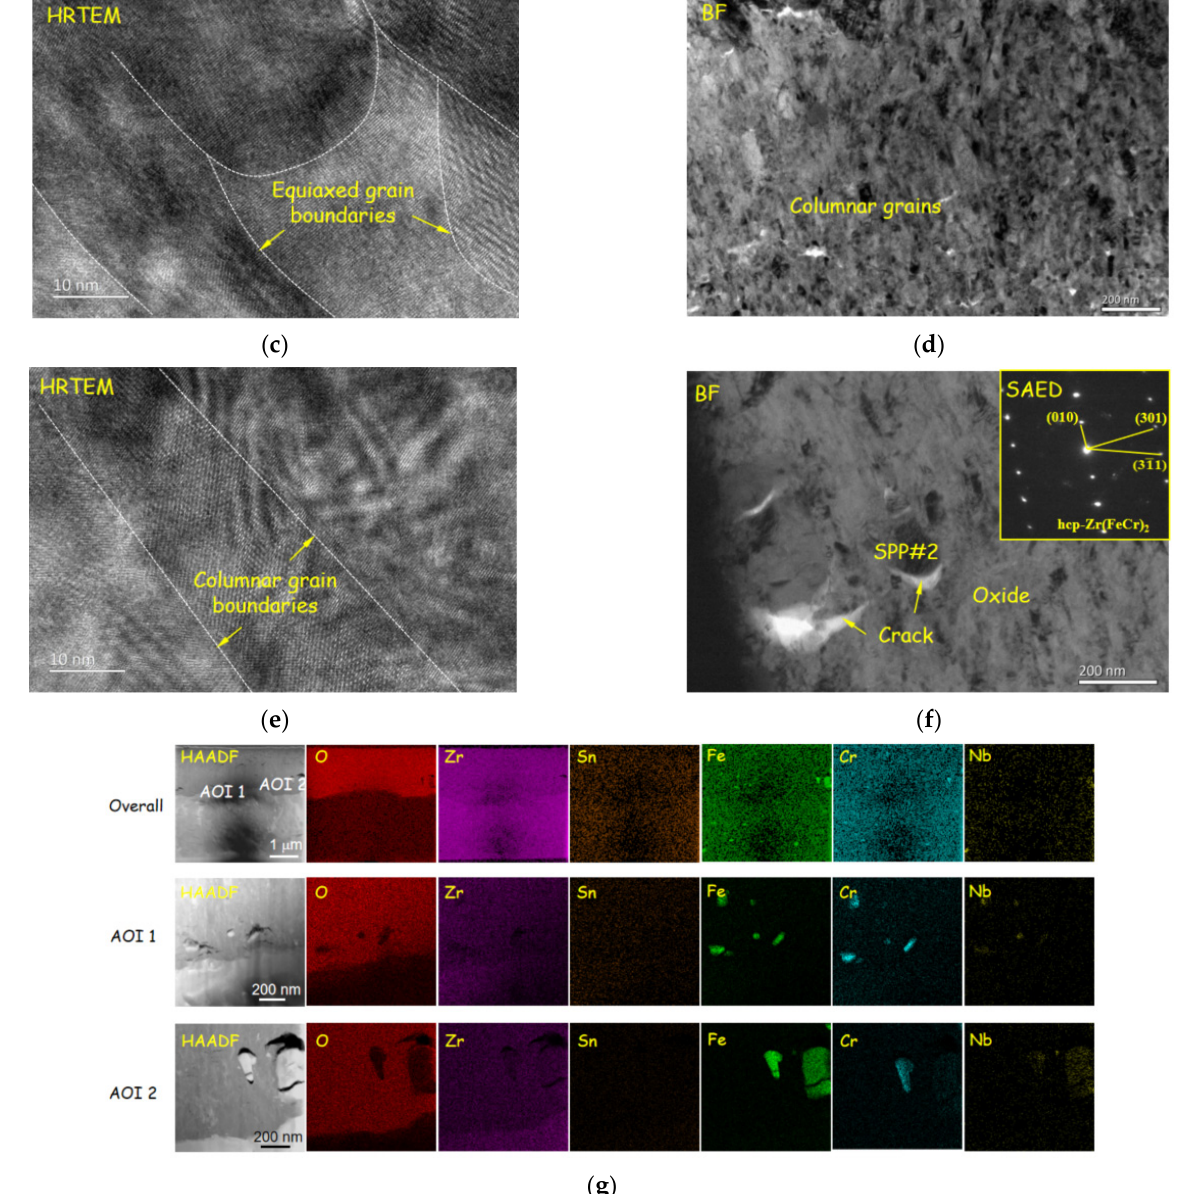
Figure 9. Oxide morphology of reprocessed plates corroded for 100 days: ( a ) overall morphology; ( b ) TEM image of equiaxed grains zone; ( c ) HRTEM image of equiaxed grains zone; ( d ) TEM image of columnar grains zone; ( e ) HRTEM image of columnar grains zone; ( f ) TEM and SAED image of SPPs embedded in oxide film, some cracks appear around SPPs; and ( g ) EDS results, which prove cracks (the dark part of the element distribution images) appear along with SPPs (concentration part of Fe, Cr and Nb) again.